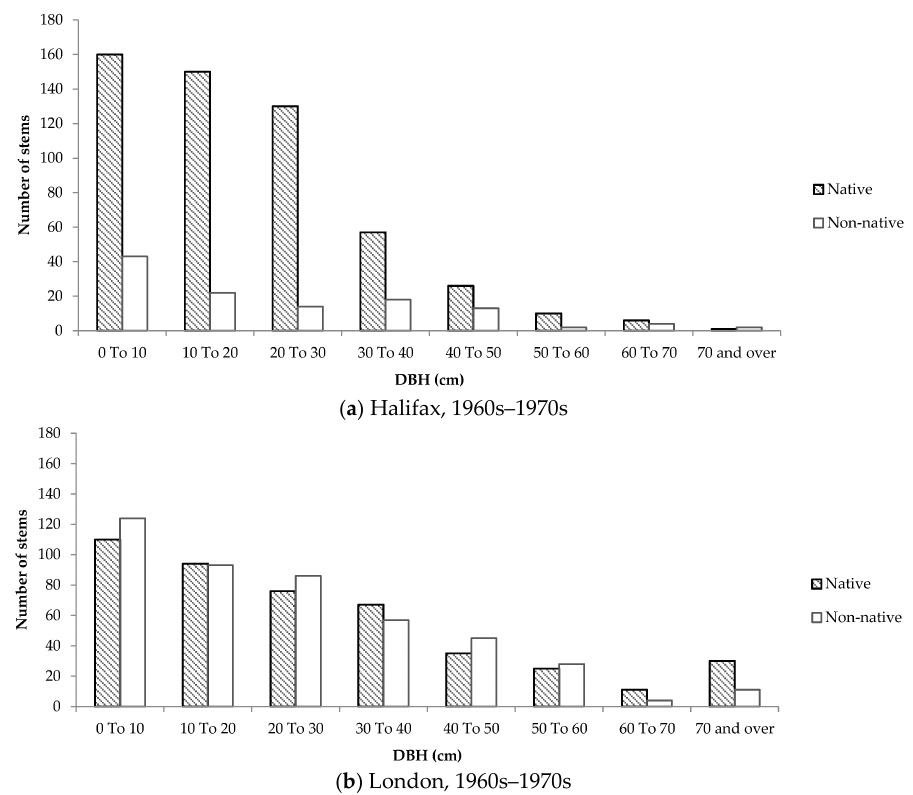
Figure 8. Size-class distribution of native and non-native trees on residential properties in neighbourhoods developed in the 1960s–1970s in: ( a ) Halifax; ( b ) London. Trees with a DBH = 10 cm, 20 cm, etc. are included in the lower histogram bin.